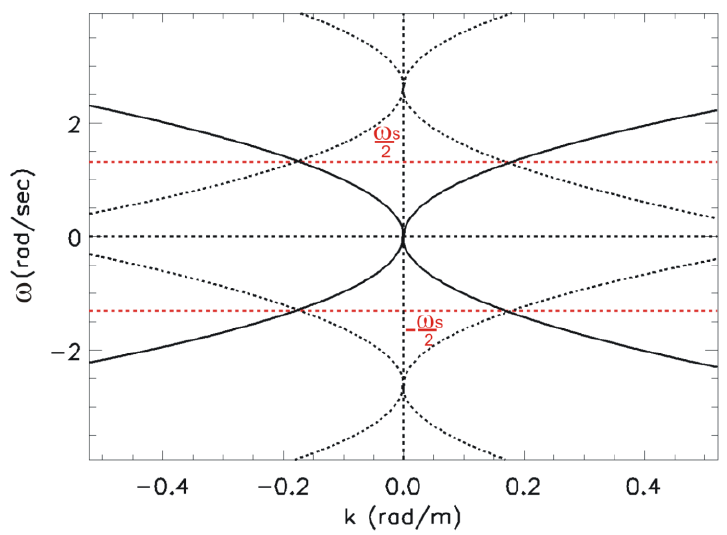
Figure 2. Folded spectrum related to the parameters of Table 1. The dotted lines depict the replicas of the spectrum.